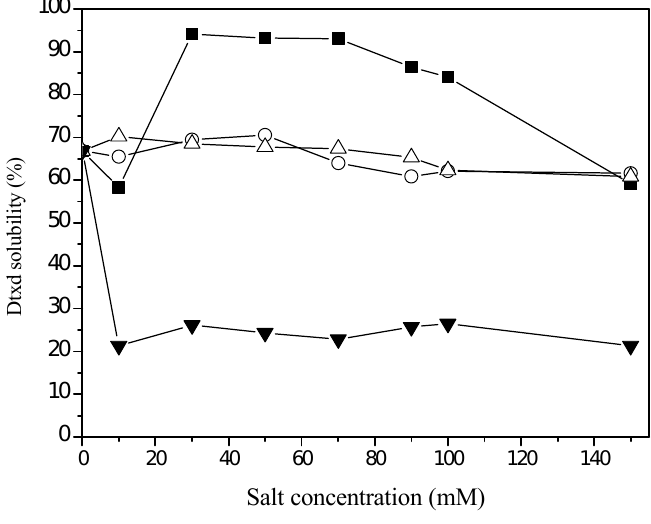
Figure 1. Effects of Hoffmeister series ions on Dtxd recovery during emulsification with Cl . The kosmotropics NaHPO CH 2 2 ( ▼ ) were added to the Dtxd water solutions and emulsified in the presence of CH 24000 rpm. The soluble protein was measured by